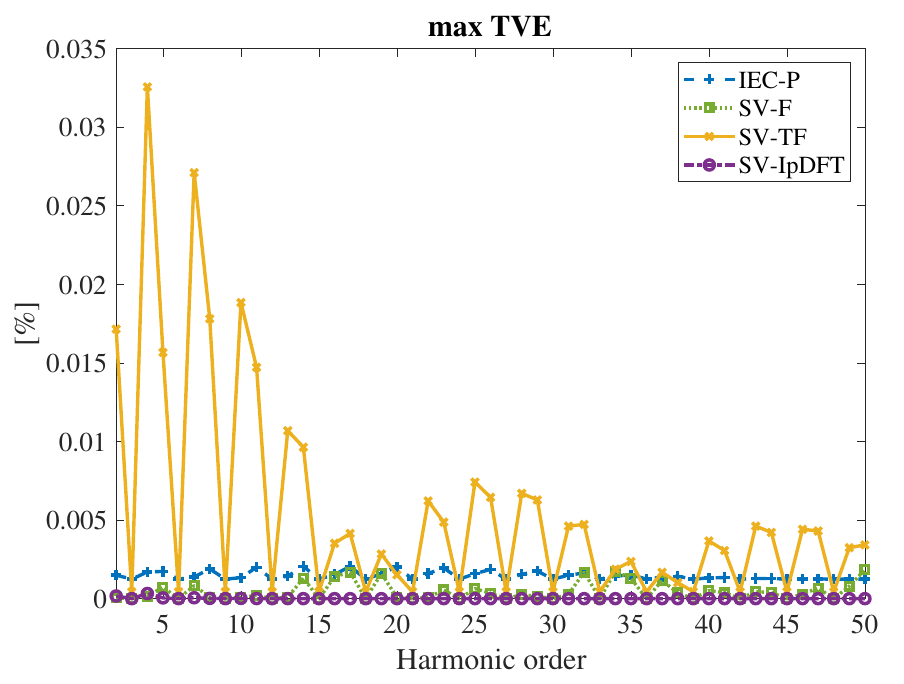
Figure 6. Maximum TVE in the presence of 1% harmonic disturbances, f = 49Hz.